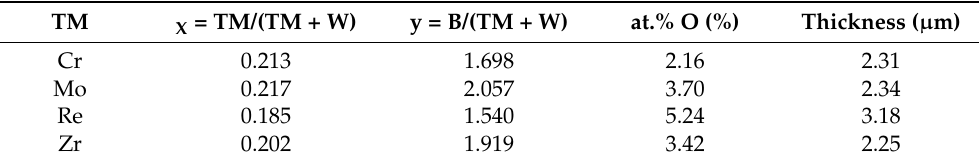
Table 4. Chemical composition and thickness of deposited coatings W 1 − x TM x B y alloyed with TM (TM = Cr, Mo, Re, Zr).